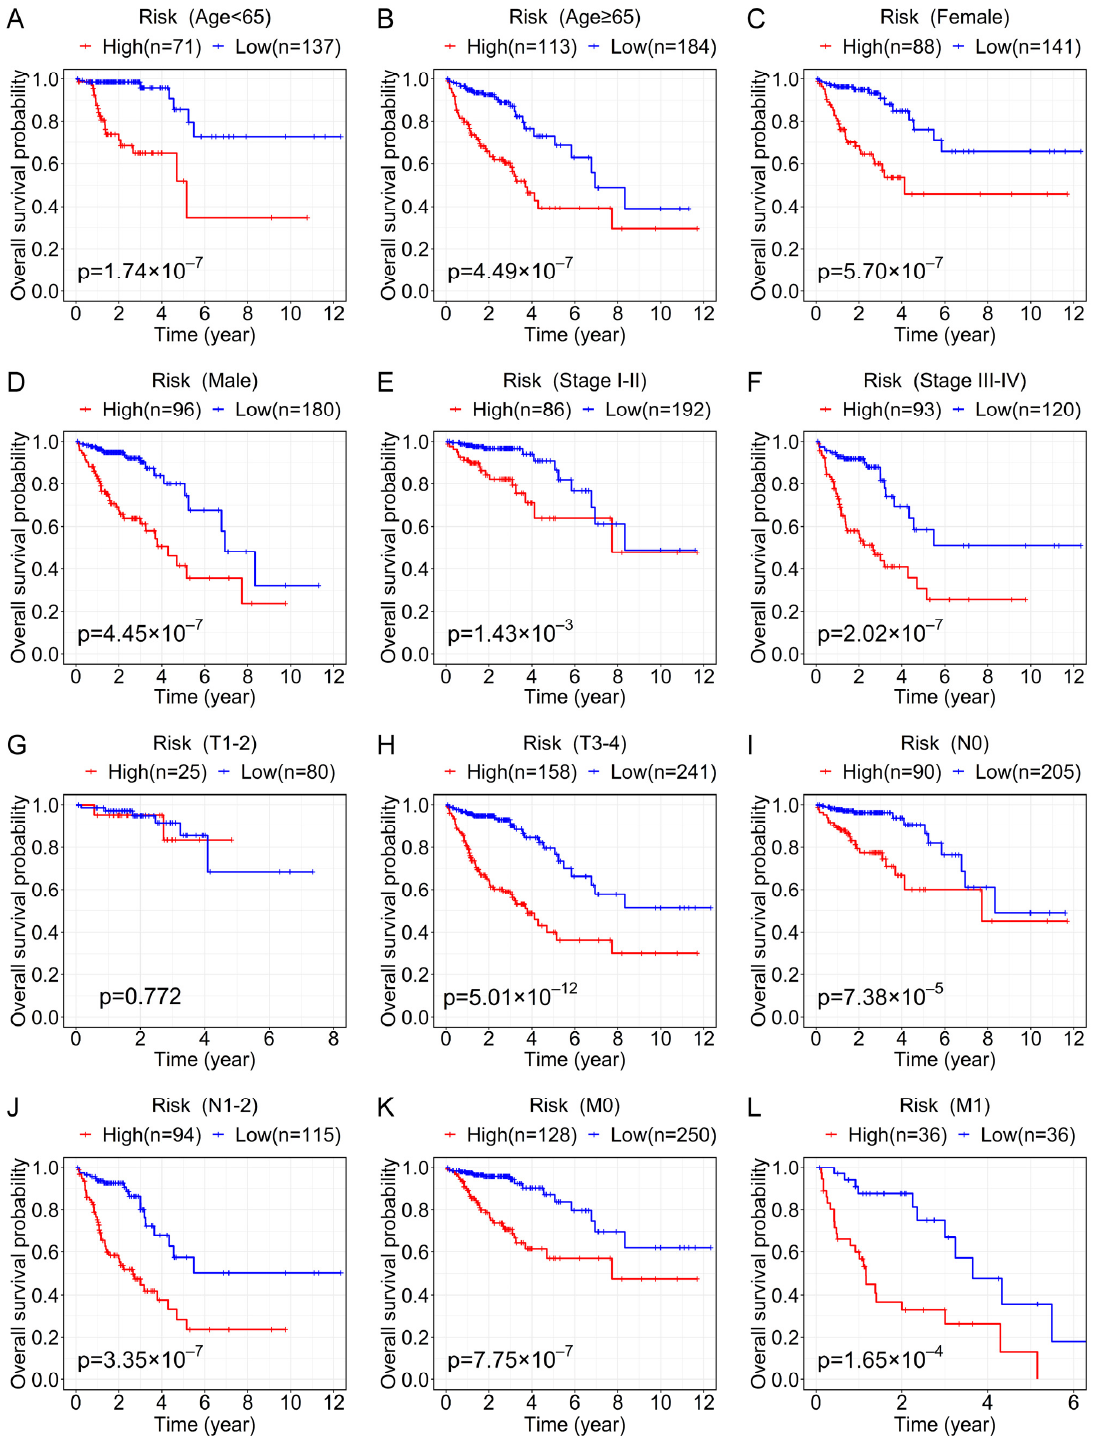
Figure 5. Prognostic value of the prognostic signature for CRC patients with different clinical characteristics. Kaplan–Meier survival curve analysis for OS shows the differences between the high- and low-risk groups in multiple clinical subgroups of CRC patients in the entire set, including age < 65 years old ( A ), age ≥ 65 years old ( B ), female ( C ), male ( D ), stage I–II ( E ), stage III–IV ( F ), T1–2 ( G ), T3–4 ( H ), N0 ( I ), N1–2 ( J ), M0 ( K ), and M1 ( L